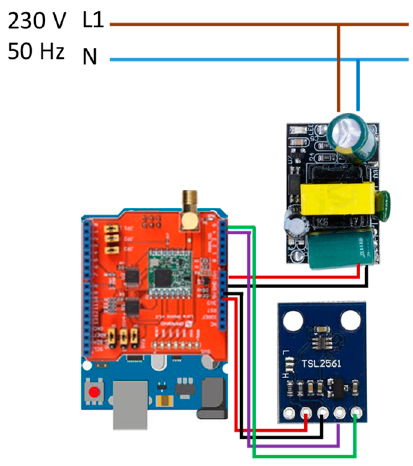
Figure 6. Hardware block diagram of LLMD.